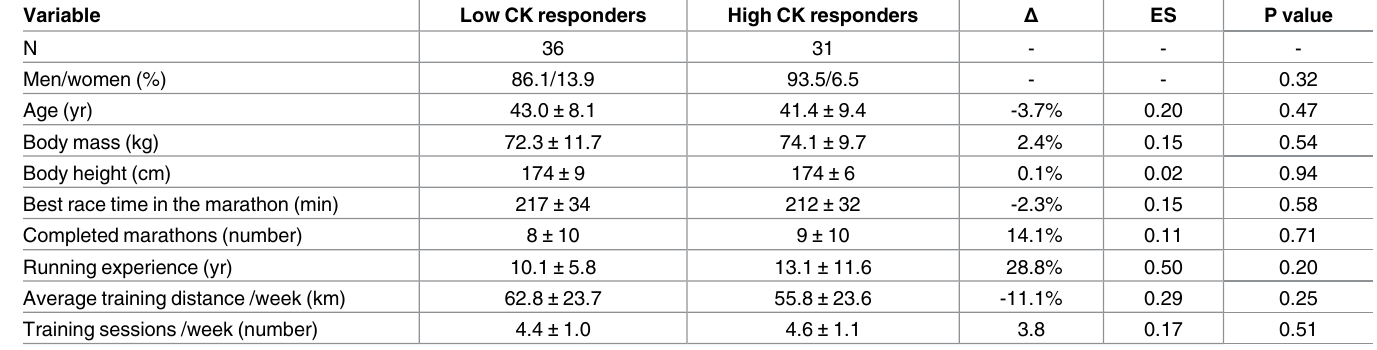
Table 1. Age, anthropometric characteristics, best race time in the marathon, running experience, and training status of runners with low and high CK responses after a marathon. Data are mean ± SD.